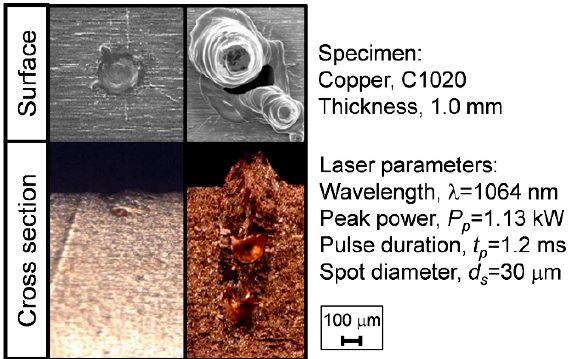
Figure 4. Molten area appearance under transitional processing condition between heat conduction and keyhole welding modes.